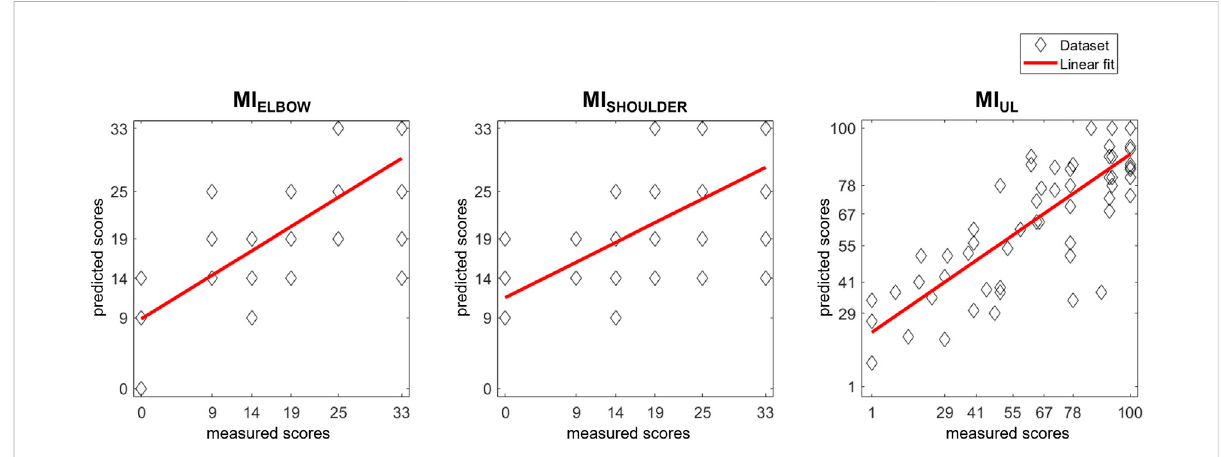
FIGURE 3 ScatterplotofMIscorespredictionwithLOOCVmodels.Eachpatient ’ sactualscorewasplottedtogetherwiththepredictionsgeneratedbythe models. The results of a linear polynomial fi tting are also shown.